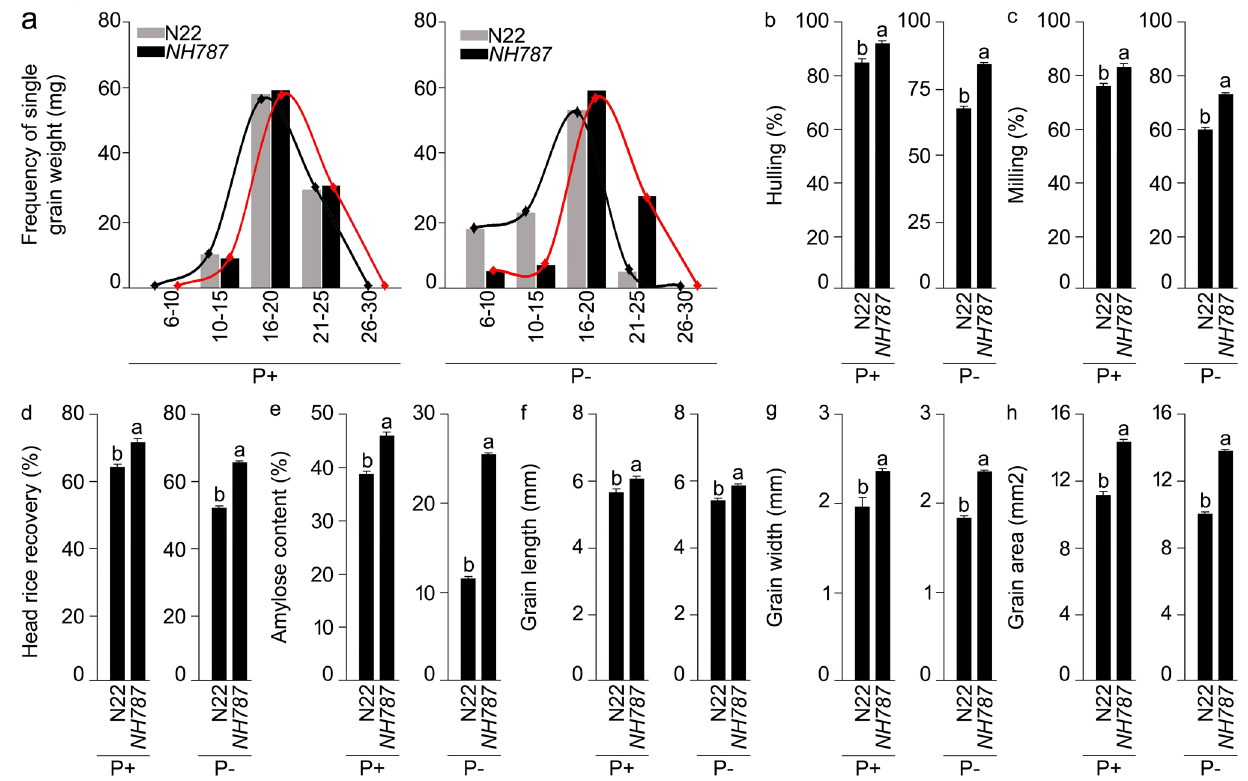
Figure 7. Effects of Pi deficiency on different grain parameters. N22 and NH787 were grown in a potting soil up to 50% flowering under P+ and P− conditions and after harvesting, grains were threshed, cleaned, and dried under natural conditions. Data are presented for ( a ) frequency of single grain weight, ( b ) percent hulling, ( c ) percent milling ( d ) percent head rice recovery, ( e ) percent amylose content, ( f ) grain length, ( g ) grain width, and ( h ) grain area. Values ( n = 3, 6, and 20 for ( a , b – e ), and ( f – h ), respectively) are means ± SE and different letters on the histograms indicate that the means differ significantly ( P < 21–25 mg, and 26–30 mg) categories and the frequency of weight distribution pattern in these categories was computed, which revealed a typical Gaussian curve (Fig. 7a). Under P+ condition, the frequency of single grain weight under different categories was comparable between N22 and NH787 (Fig. 7a). However, significant vari- ation in the frequency of single grain weight was observed under P− condition for N22 compared with NH787 ranging from higher (6–10 mg and 10–15 mg), lower (16–20 mg and 21–25 mg), and comparable (26–30 mg) values (Fig. 7a). The analysis revealed that NH787 seeds were comparatively more robust than N22 when grown under Pi-deprived condition. Under both P+ and P− conditions, several grain quality parameters of NH787 were significantly higher than N22 comprising hulling (P+ [8.07%], P− [24.18%]) (Fig. 7b), milling (P+ [9.48%], P− [21.21%]) (Fig. 7c), percent head rice recovery (P+ [11.79%], P− [26.54%]) (Fig. 7d), percent amylose content (P+ [18.23%], P− [2.21 fold]) (Fig. 7e), grain length (P+ [7.07%], P− [8.47%]) (Fig. 7f), grain width (P+ [20.30%], P− [27.71%]) (Fig. 7g), and grain area (P+ [28.72%], P− [38.42%]) (Fig. 7h). Different parameters such as alkali spread value, gelatinization temperature, and gel consistency are conventionally used for determining the gain